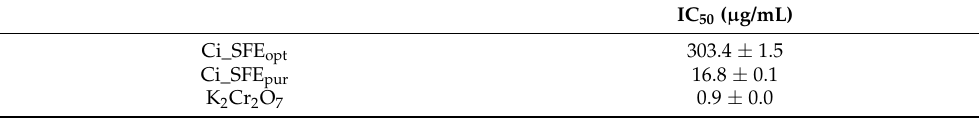
Cytotoxicity of Ci_SFE opt and Ci_SFE pur toward HaCaT cells, presented as the IC 50 value ( µ g/mL). K 2 Cr 2 O 7 was used as a positive control. Results are expressed as mean ( ± stdev) of